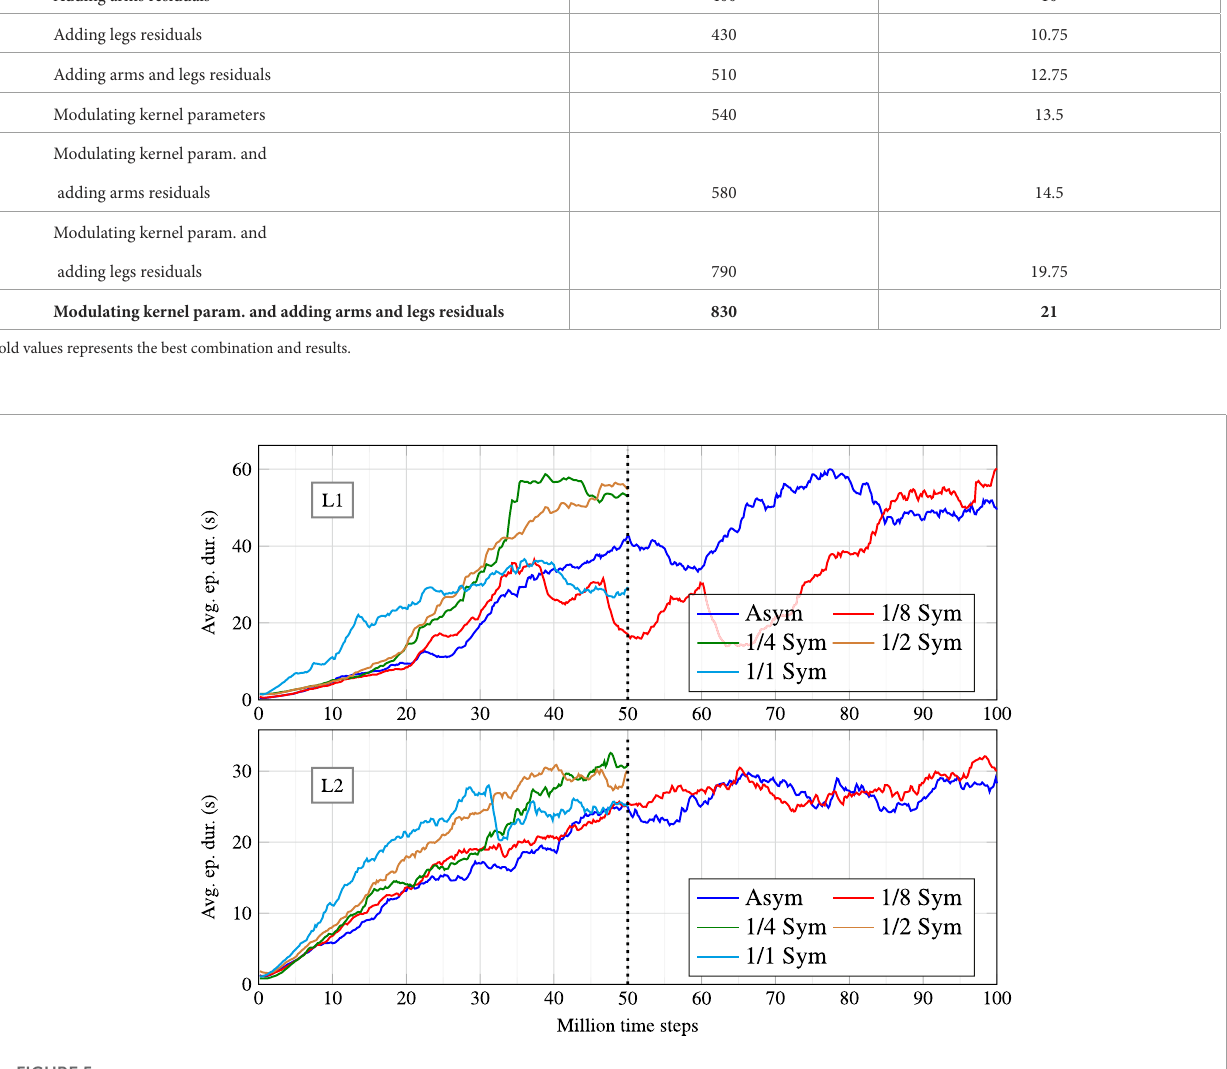
results showed that 380 N (impulse 9.5 N s) was the maximum force that the robot could